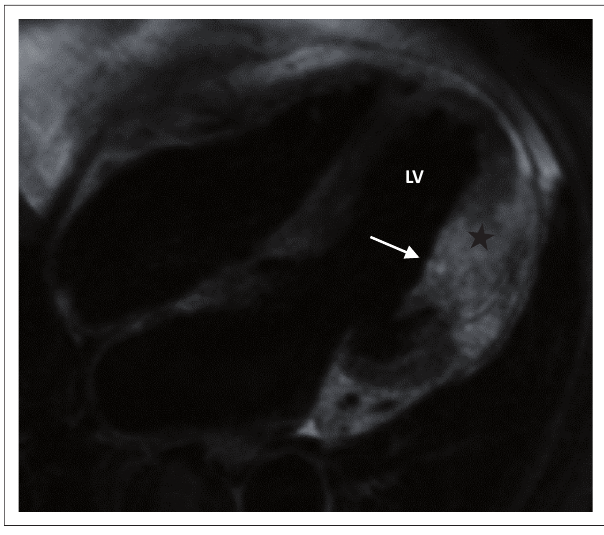
FIGURE 11: Axial SPAIR image demonstrates extension of a myocardial tumour (*) into the papillary muscle (white arrow).